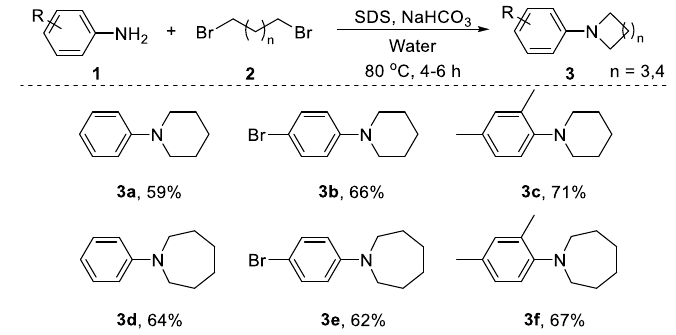
Figure 1. Several drugs bearing the azacycle moiety.